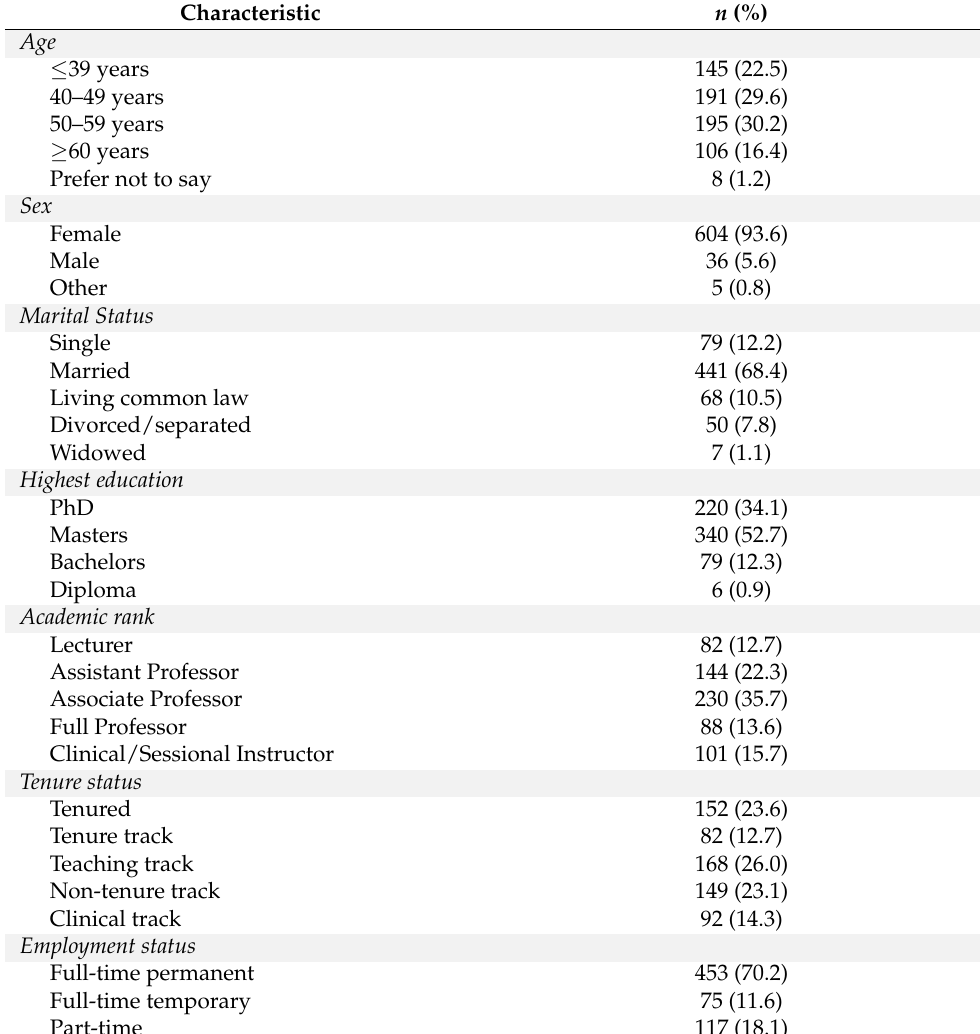
Table 2. Demographic characteristics of the